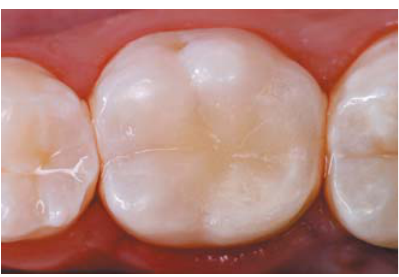
FIGURE 11- Radiograph showing sound tooth and periodontal structures after 4- year follow-up